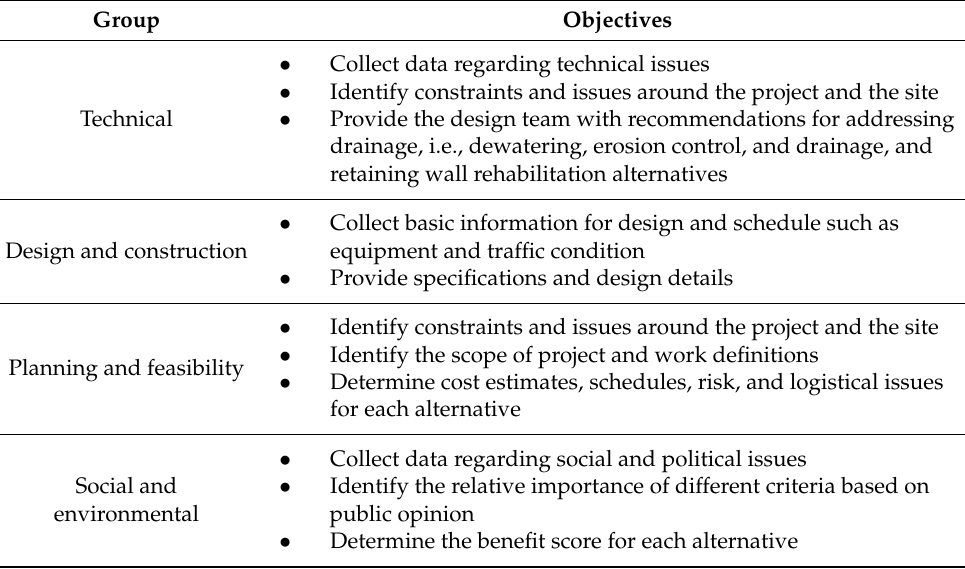
Table 2. Student grouping and